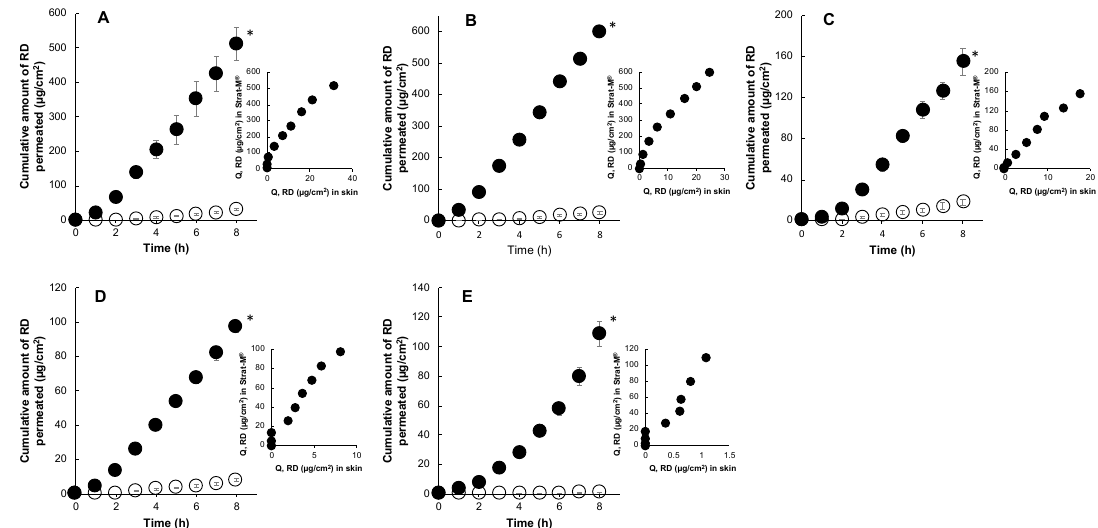
Figure 3. Time course of the cumulative amount of RD that permeated through Strat-M ® ( ● ) and porcine skin ( ○ ) and their correlations under infinite dose conditions. 1% RD in water ( A ), 2% RD in 19.5% polyol ( B ), 2% RD in 40% polyol ( C ), 2% RD in 61.8% polyol ( D ), and 2% RD in 100% polyol ( E ). Each point represents the mean ± S.E. ( n = 4). There was a significant difference (* p < 0.05) between RD permeation through Strat-M ® and porcine skin.